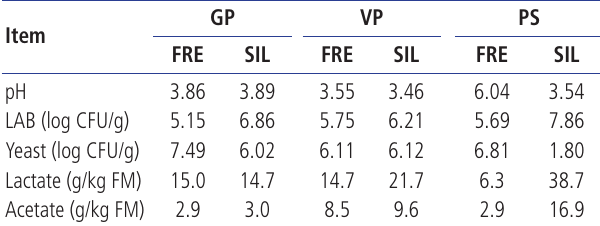
Table 2. Profiles of fruits byproducts and its silages tested in in vitro experiments